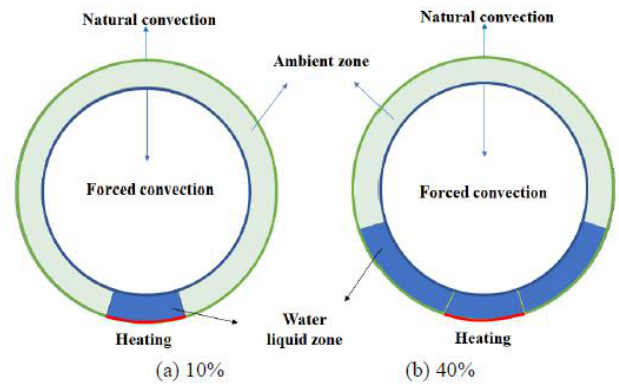
Figure 3. 2D modeling geometry with different filling rate.